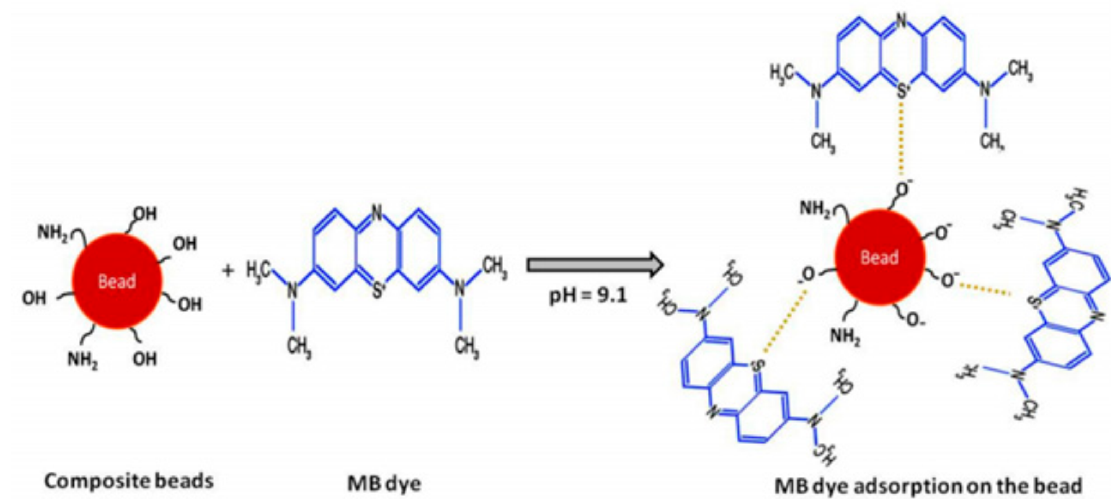
Figure 2. The mechanism of methylene blue (MB) removal over clay-polymer composite